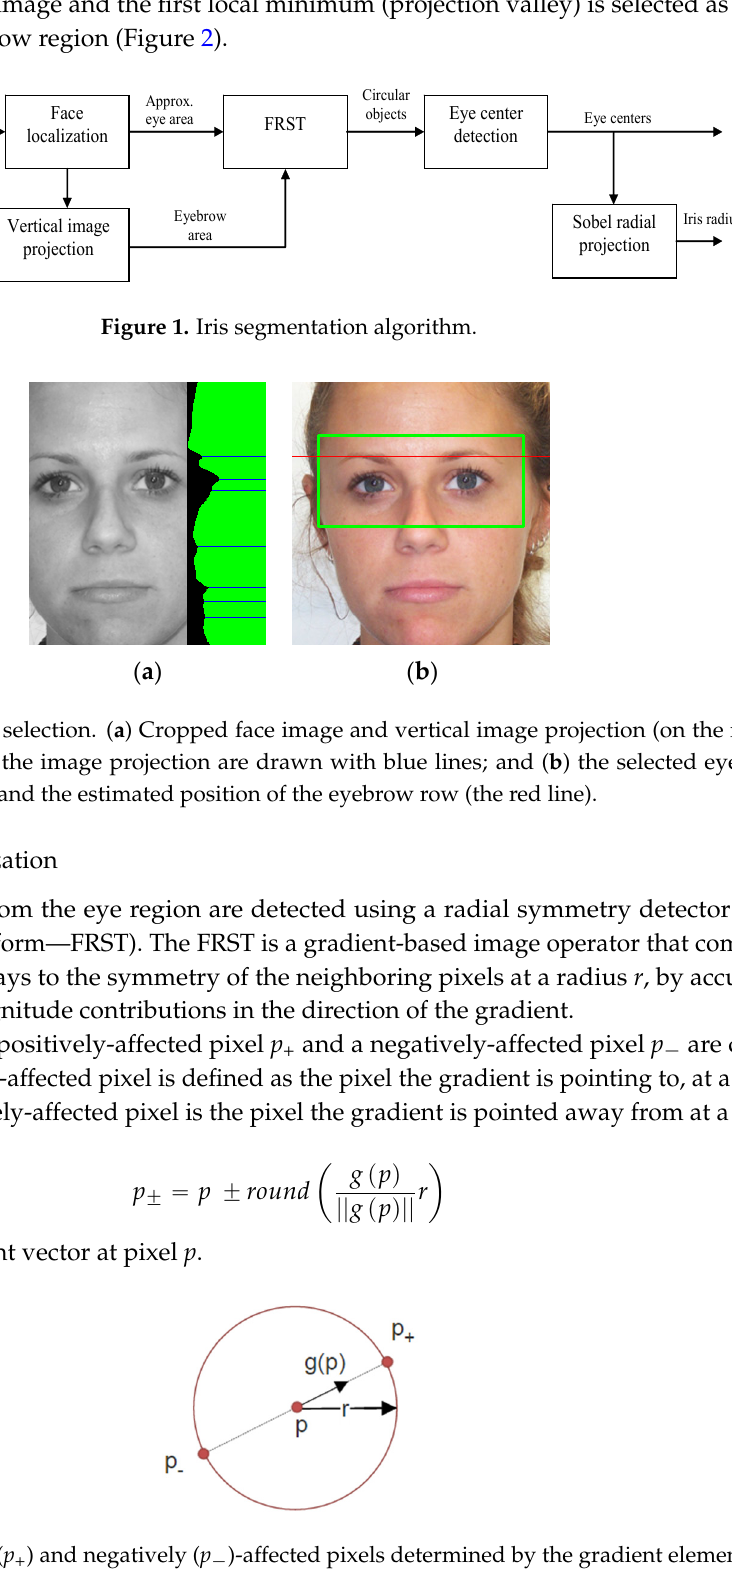
Figure 3. Positively- ( p + ) and negatively ( p − )-affected pixels determined by the gradient element g(p) for a radius r (after [23]).